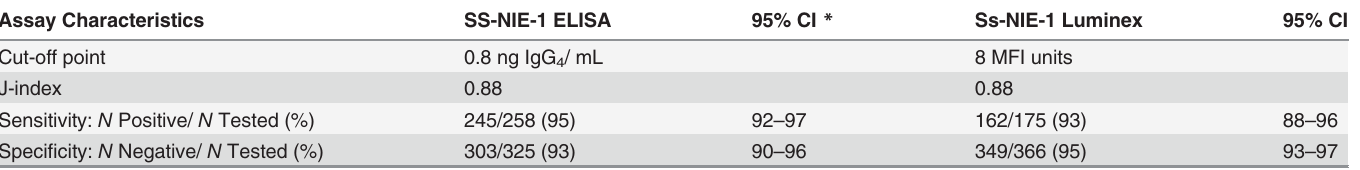
Table 1. Performance of SS-NIE-1 ELISA and Luminex. Assay Characteristics